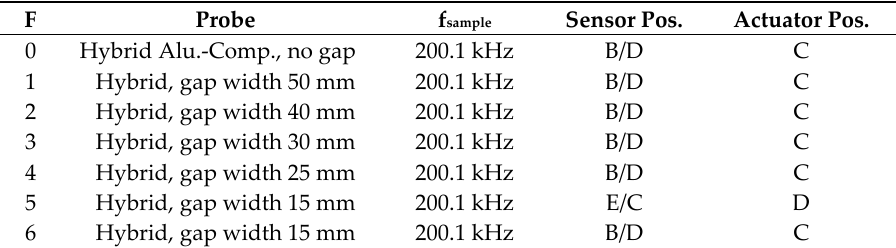
Table 2. Signal data sets and analysis